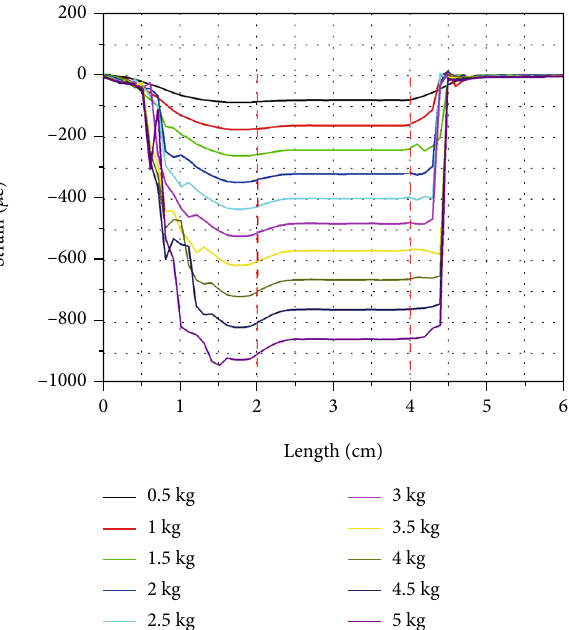
Figure 7: Measured results of FBG sensor in the test on beam of constant